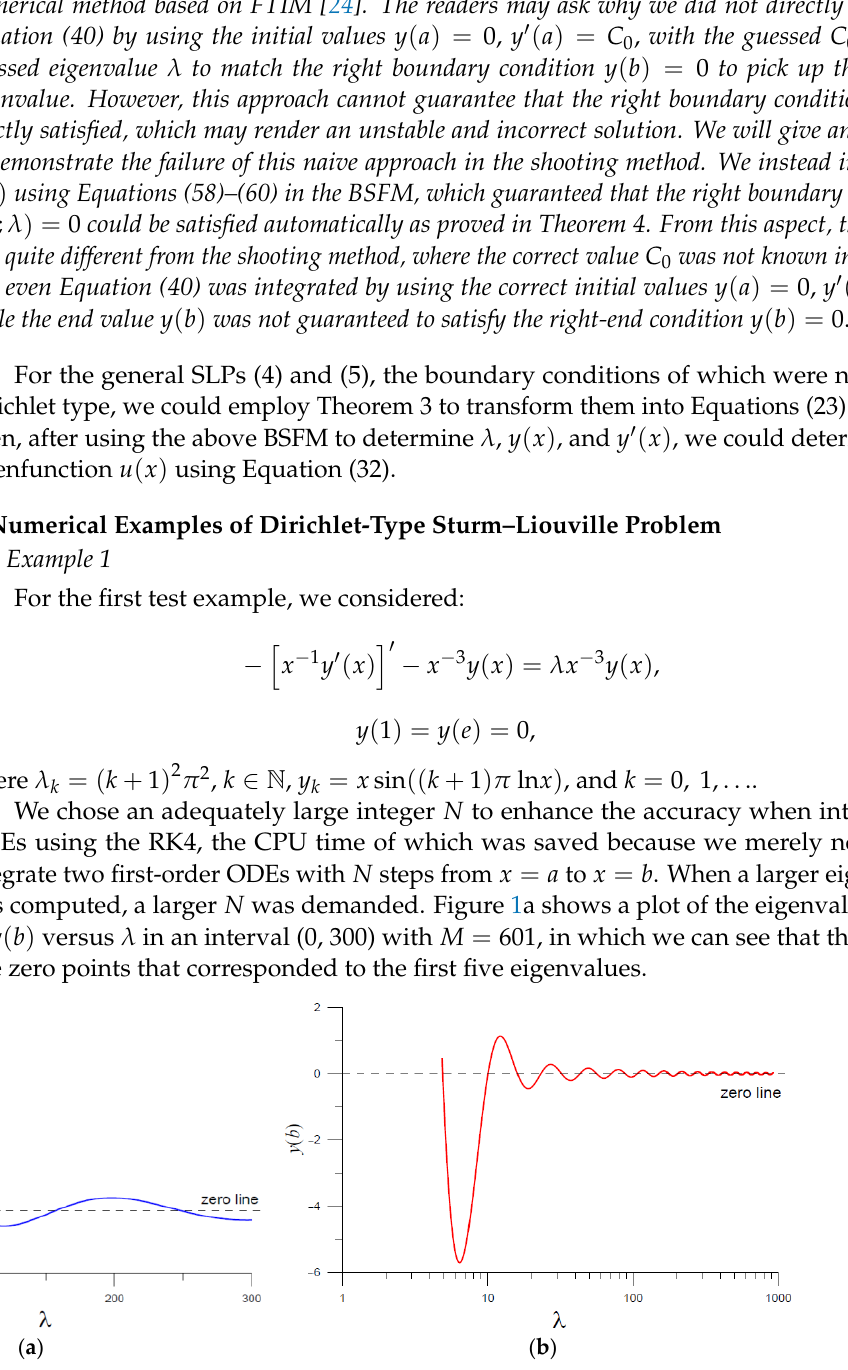
Figure 1. Plotting the eigenvalue curves for ( a ) Example 1 and ( b ) Example 2.